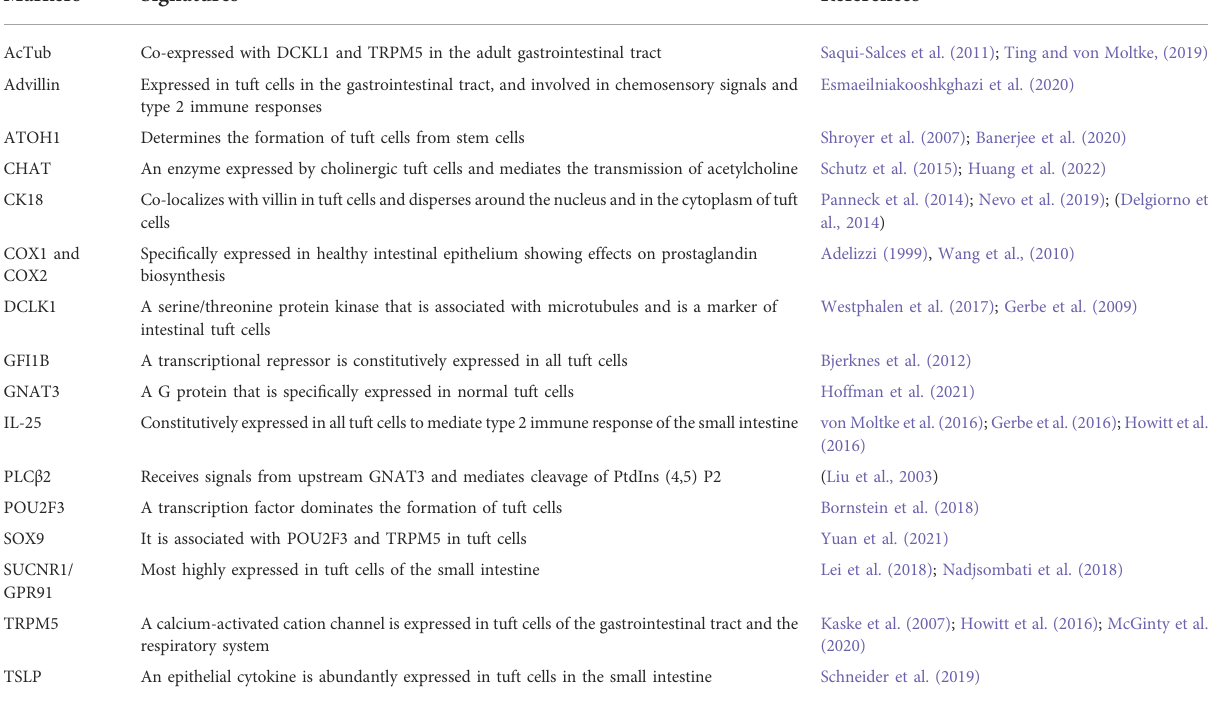
TABLE 1 The markers of tuft